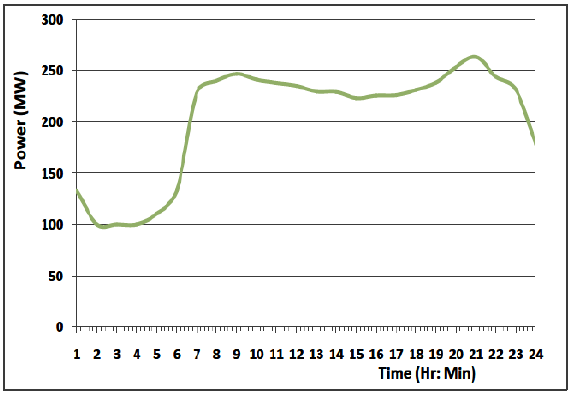
Figure 5. Typical summer time load profile.